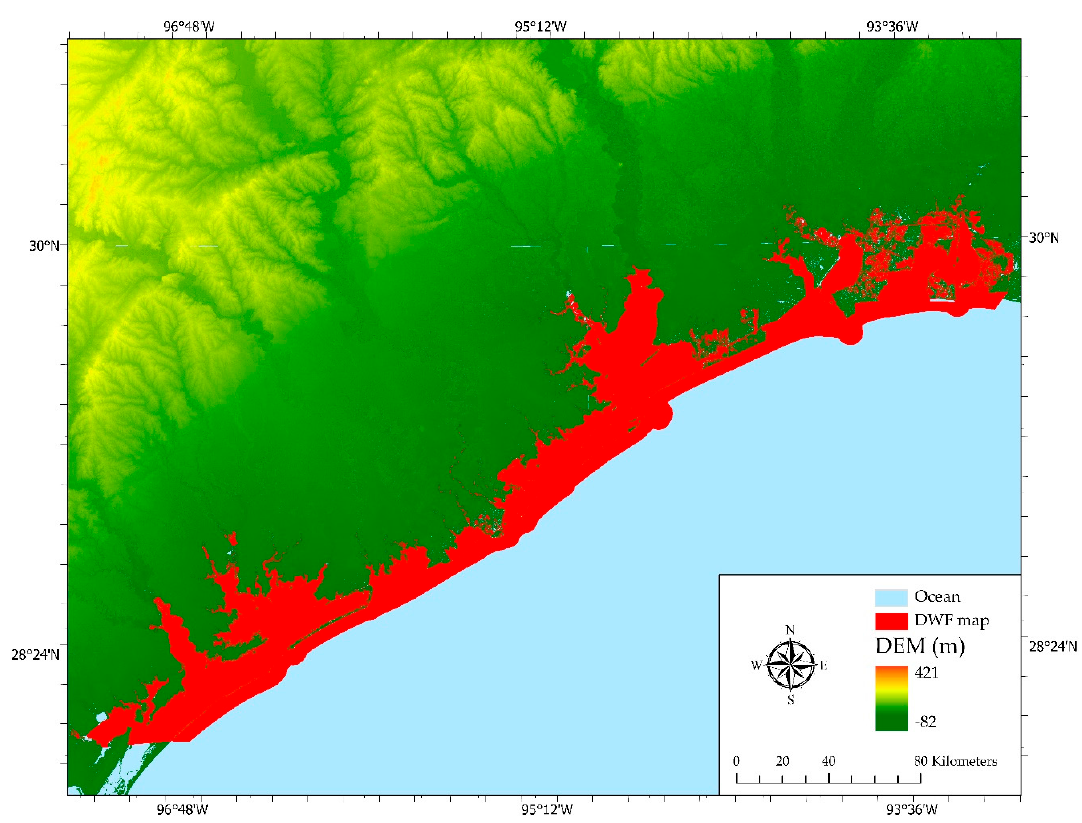
Figure 7. DEM-based water fraction (DWF) map developed from WF map using SRTM DEM data.